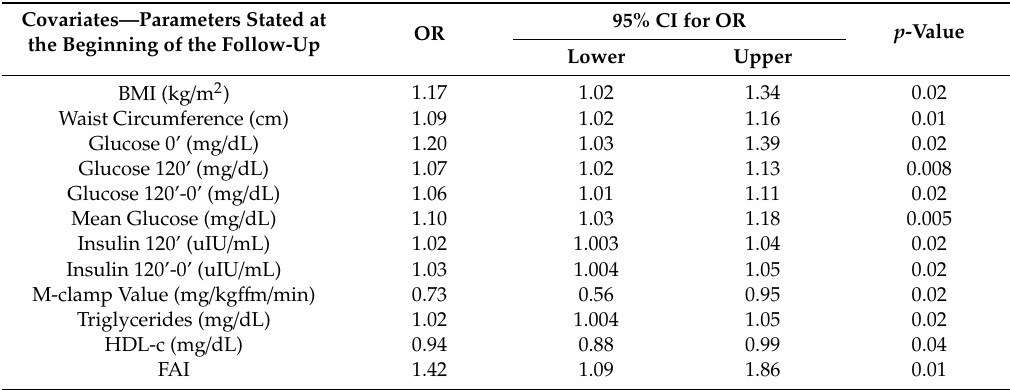
Table 8. Significant predictors of prediabetes in women with a history of